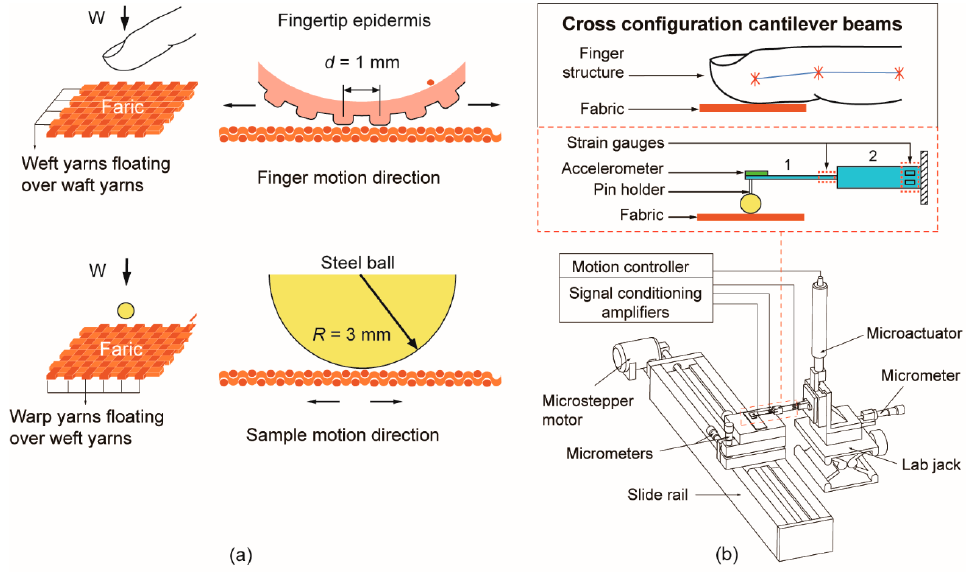
Figure 1. ( a ) Schematic illustrating the processes of human tactile perception by an index fingertip and a steel ball probe, when they are sliding on the surface of 1/1 plain weave fabrics consisting of weft and warp yarns in each direction. ( b ) A finger biological structure-inspired tactile sensor